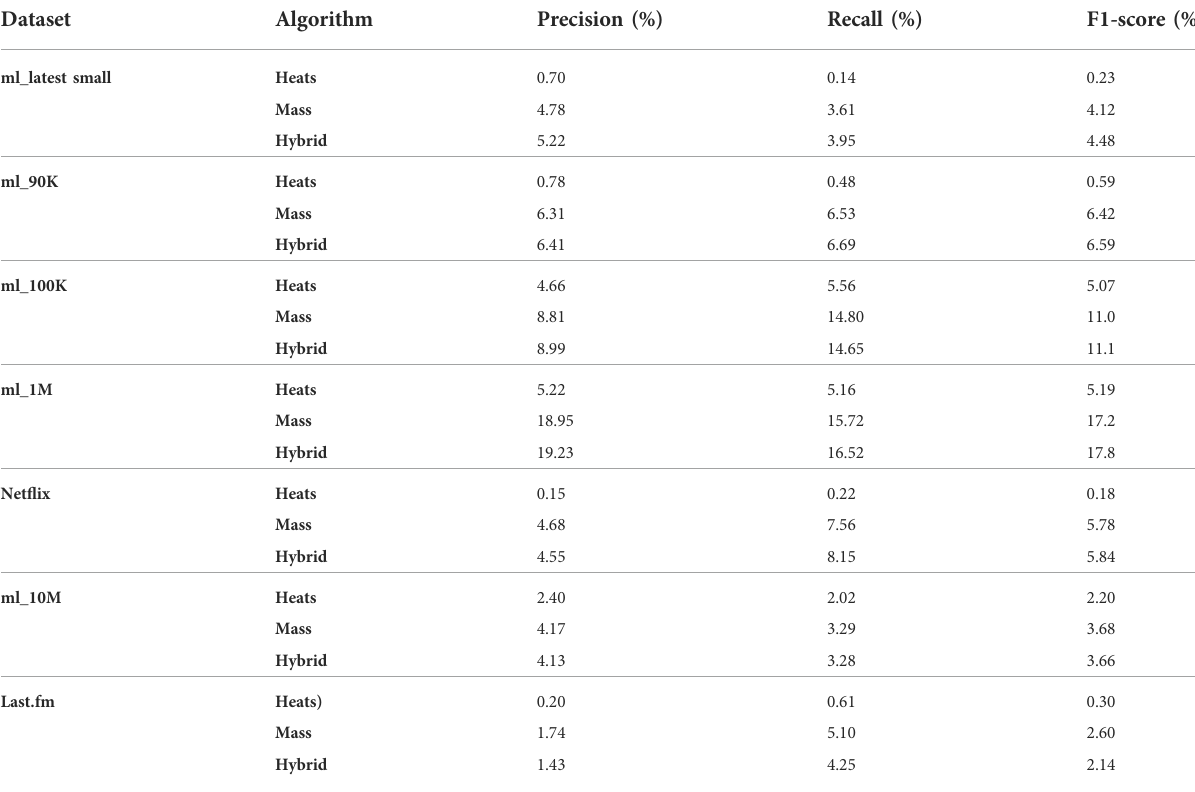
TABLE 3 Recommendation evaluations on seven datasets with temporal selection of test sets.